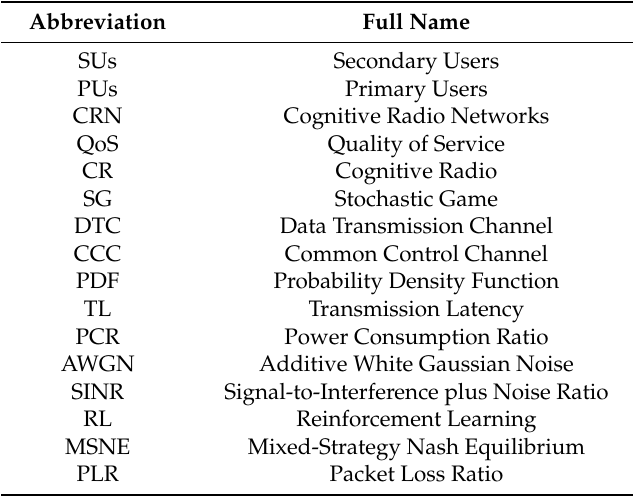
Table 1. List of Acronyms.